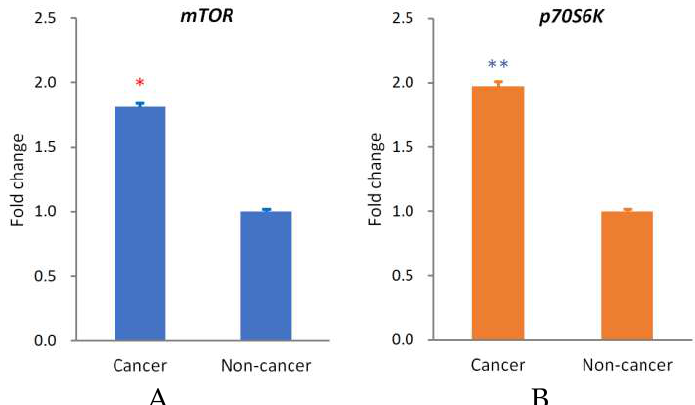
Figure 1. Expression of mTOR and p70S6K of squamous cell carcinoma (OSCC). Expression of mTOR ( A ) and p70S6K ( B ) was upregulated in the cancerous tissue of OSCC ( p < 0.05 and 0.01, respectively). The y -axis represents the fold change in the mTOR or p70S6K expression level of cancerous relative to noncancerous tissues. The mean mTOR or p70S6K expression level in noncancerous tissues was assigned a value of 1 to obtain the fold change in expression in cancerous tissues. The mean ∆ Ct values for mTOR are 5.98 ± 0.26 (cancer parts) and 6.84 ± 0.22 (noncancer parts), and for p70S6K are 6.03 ± 0.31 (cancer parts) and 7.01 ± 0.19 (noncancer parts).The red * p < 0.05 and blue ** p < 0.01 indicate the statistical significance of differences between the cancer parts and noncancer parts.